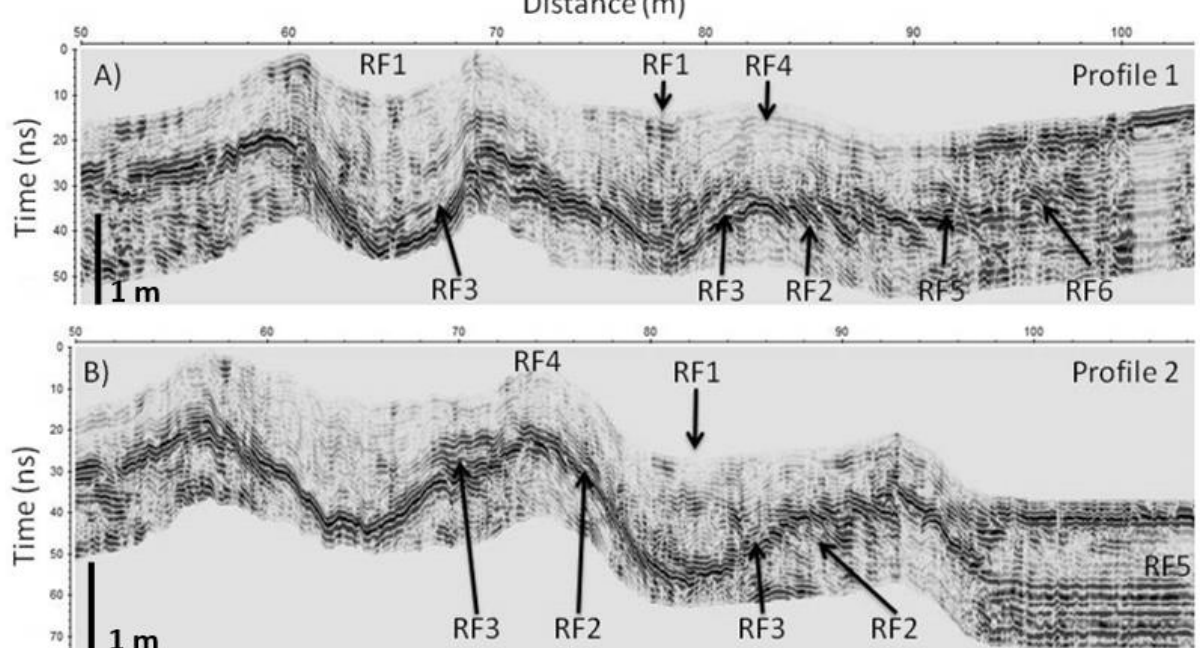
Figure 6. Terminal section of the GPR profiles from land (left) to sea (right), from the mid dune system to the beach: ( A ) Profile 1, and ( B ) Profile 2, (see Figure 1 for location). On the profiles are indicated the different radar facies used in their interpretation (described in the text). RF1 facies is the result of the filling of interdune grooves, RF2 facies show wind deposits in the seaside zone of the dunes, RF3 facies are deposits due to washover processes or aeolian deposits filling interdune depressions, RF4 is due to sedimentary accumulation with vegetation, and facies RF5 and RF6 are interpreted as beach deposits and the formation of berms or foreshore bars, respectively.